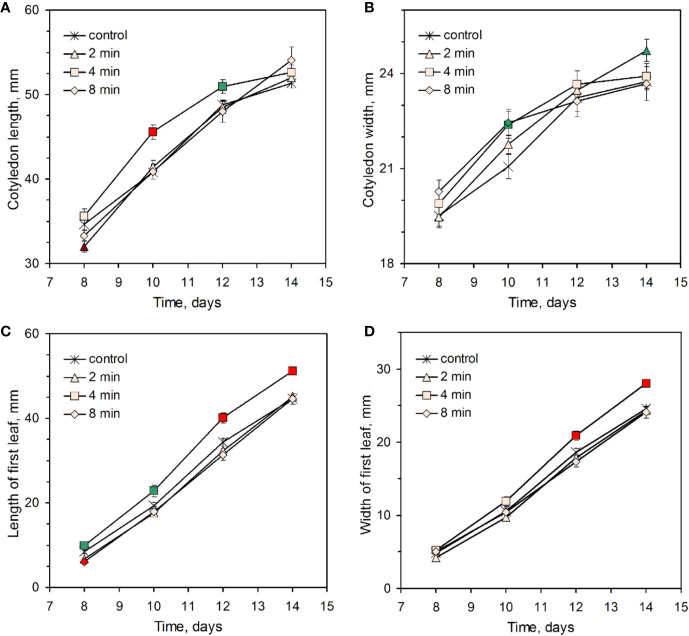
Effect of plasma treatment on sunflower seedling cotyledon (A, B) and first leaf (C, D) length (A, C), and width (B, D). Data from six independent experiments is presented as mean and standard error of the mean. Color of the symbols represent significant differences of the mean values compared to the control (green – p < 0.05, red – p < 0.01).